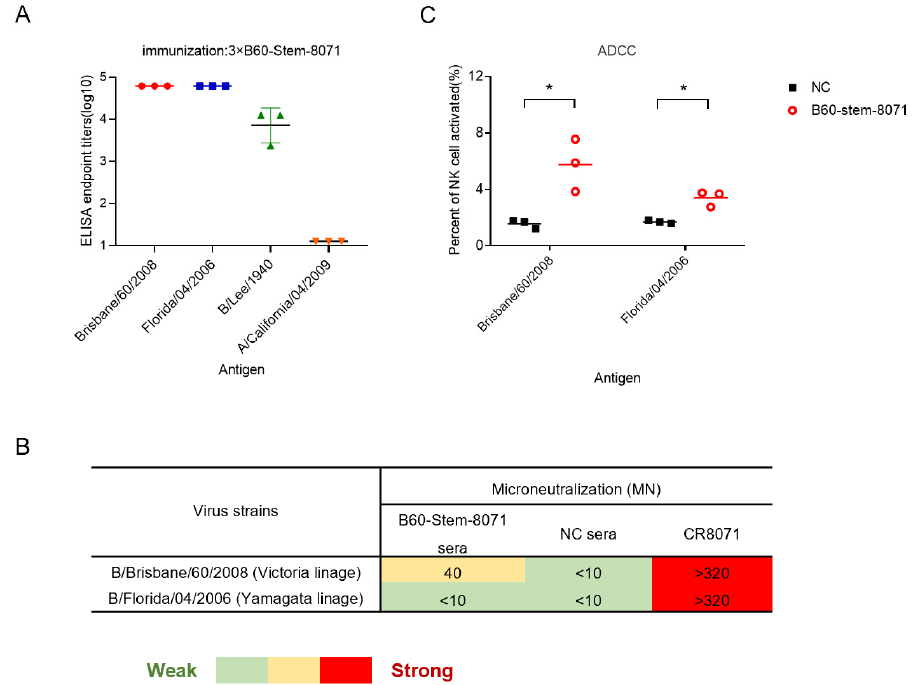
Figure 4. Reactivity of sera from mice vaccinated with B60-stem 8071 against divergent IBV in vitro. ( A ) Broad binding activity of sera from mice vaccinated with B60-stem-8071 against representative inactivated viruses from three influenza B lineages and an IAV pdmH1N1 strain by ELISA. ( B ) Neu- tralization activity of sera from mice vaccinated with B60-stem-8071 or adjuvant (NC group) to IBV by MN assay. The neutralization strength is color coded from green (weak) to red (strong). The value <10: no reactivity (filled with green); 10–40: moderate reactivity (filled with yellow); >40: high reactivity (filled with red). Asterisks represented significant differences Significance (* p < 0.05). ( C )The ADCC effect of sera from mice vaccinated with B60-stem-8071 or NC